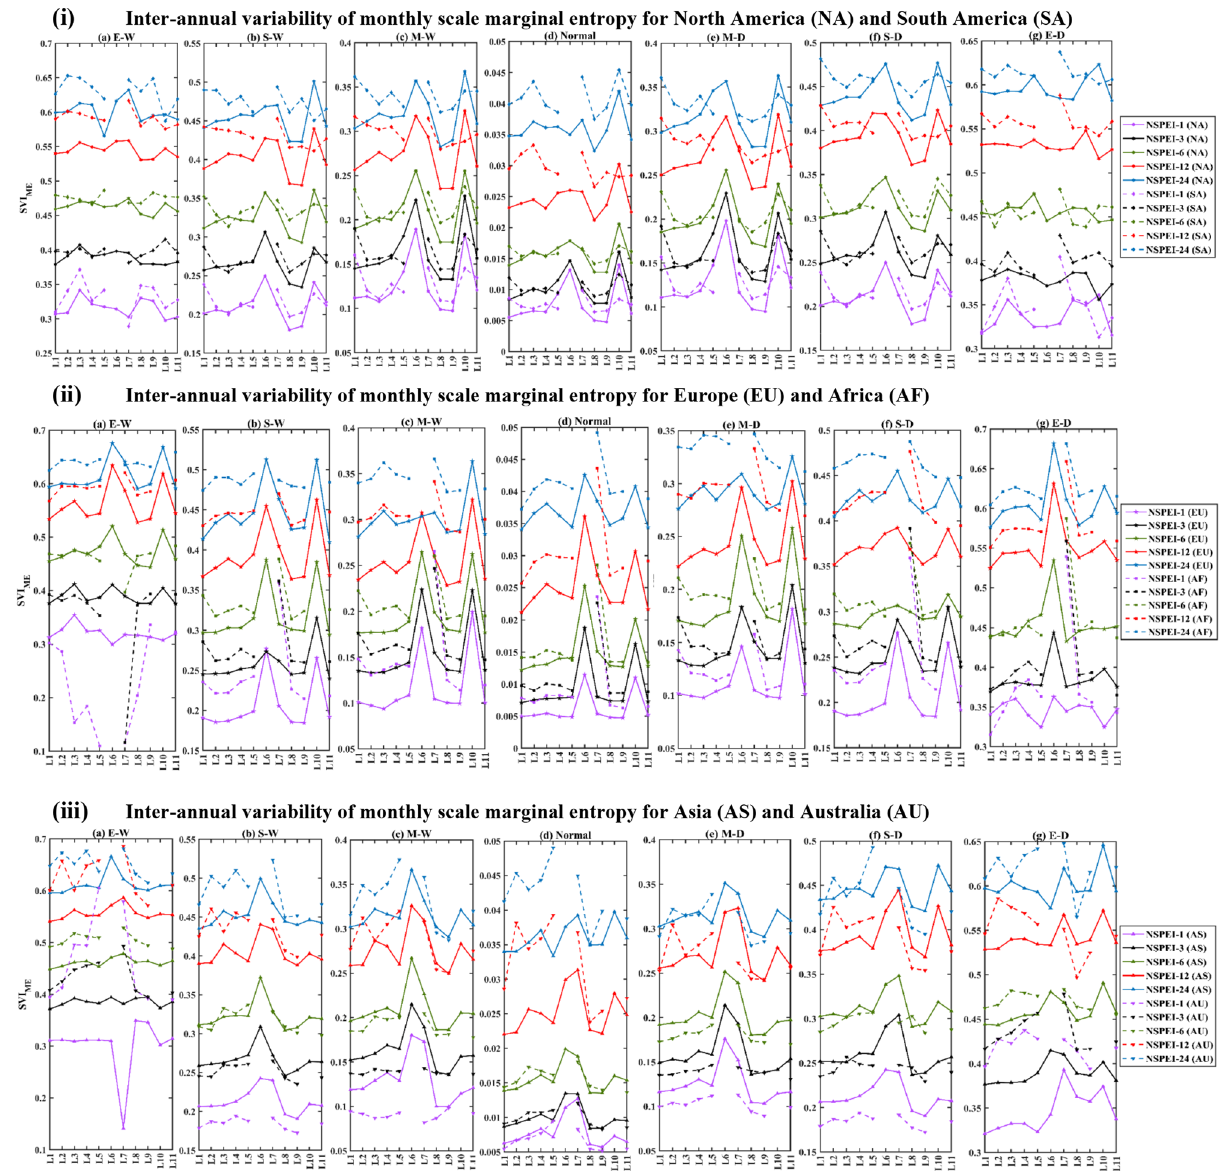
Figure 4. Monthly scale inter-annual variability (SVI ME ) of wet, normal and dry conditions for different LULC classes in (i) North America and South America, (ii) Africa and Europe (iii) Asia and Australia. The LULC classes are L1: Closed Forest; L2: Open Forest; L3: Shrublands; L4: Herbaceous vegetation; L5: Herbaceous wetlands; L6: Moss and lichen; L7: Bare vegetation; L8: Cropland; L9: Built-up land; L10: Snow and ice; L11: Water bodies. In the notation NSPEI- M , M indicates the accumulation period (AP) in months. Extreme, severe and moderate-intensity levels of wet conditions are denoted by E-W, S-W, M-W, respectively. The corresponding intensity levels in the case of dry conditions are denoted by E-D, S-D, M-D, respectively. *The plots were generated using MATLAB (version: